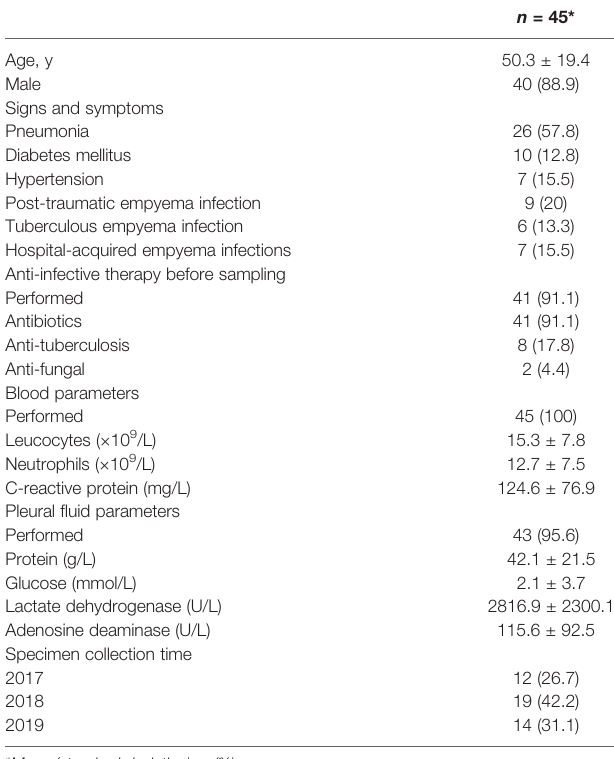
TABLE 1 | Basic characteristics of the study participants with pleural